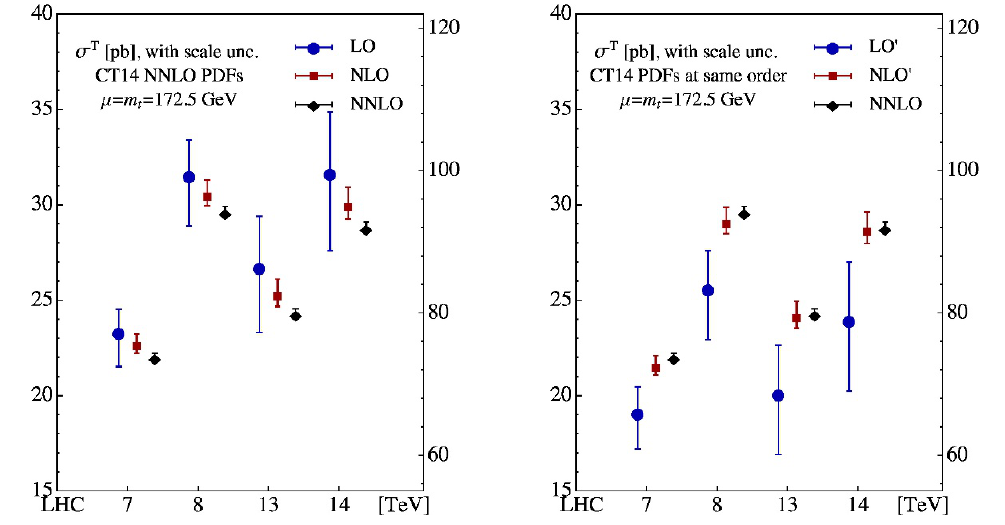
Figure 13 . Inclusive cross sections for t -channel single top anti-quark production, similar to (cid:12)gure 12.